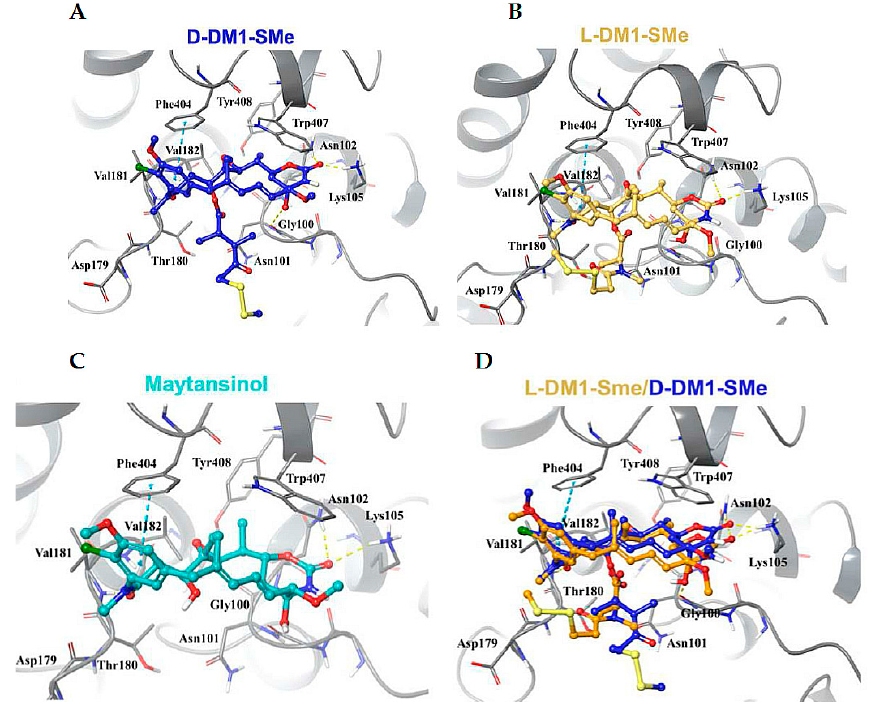
Figure 18. ( A ) Interactions between tubulin (grey ribbons and grey sticks) and D-DM1-SMe (yellow sticks); ( B ) interactions between tubulin (grey ribbons and grey sticks) and L-DM1-SMe (blue sticks); ( C ) interactions between tubulin (grey ribbons and grey sticks) and maytansinol (cyan sticks); ( D ) overlay of the binding poses of L-DM1-SMe (yellow sticks) and D-DM1-SMe (blue sticks). Reprinted with permission from Ref. [112]. Copyright© (2021), Elsevier.